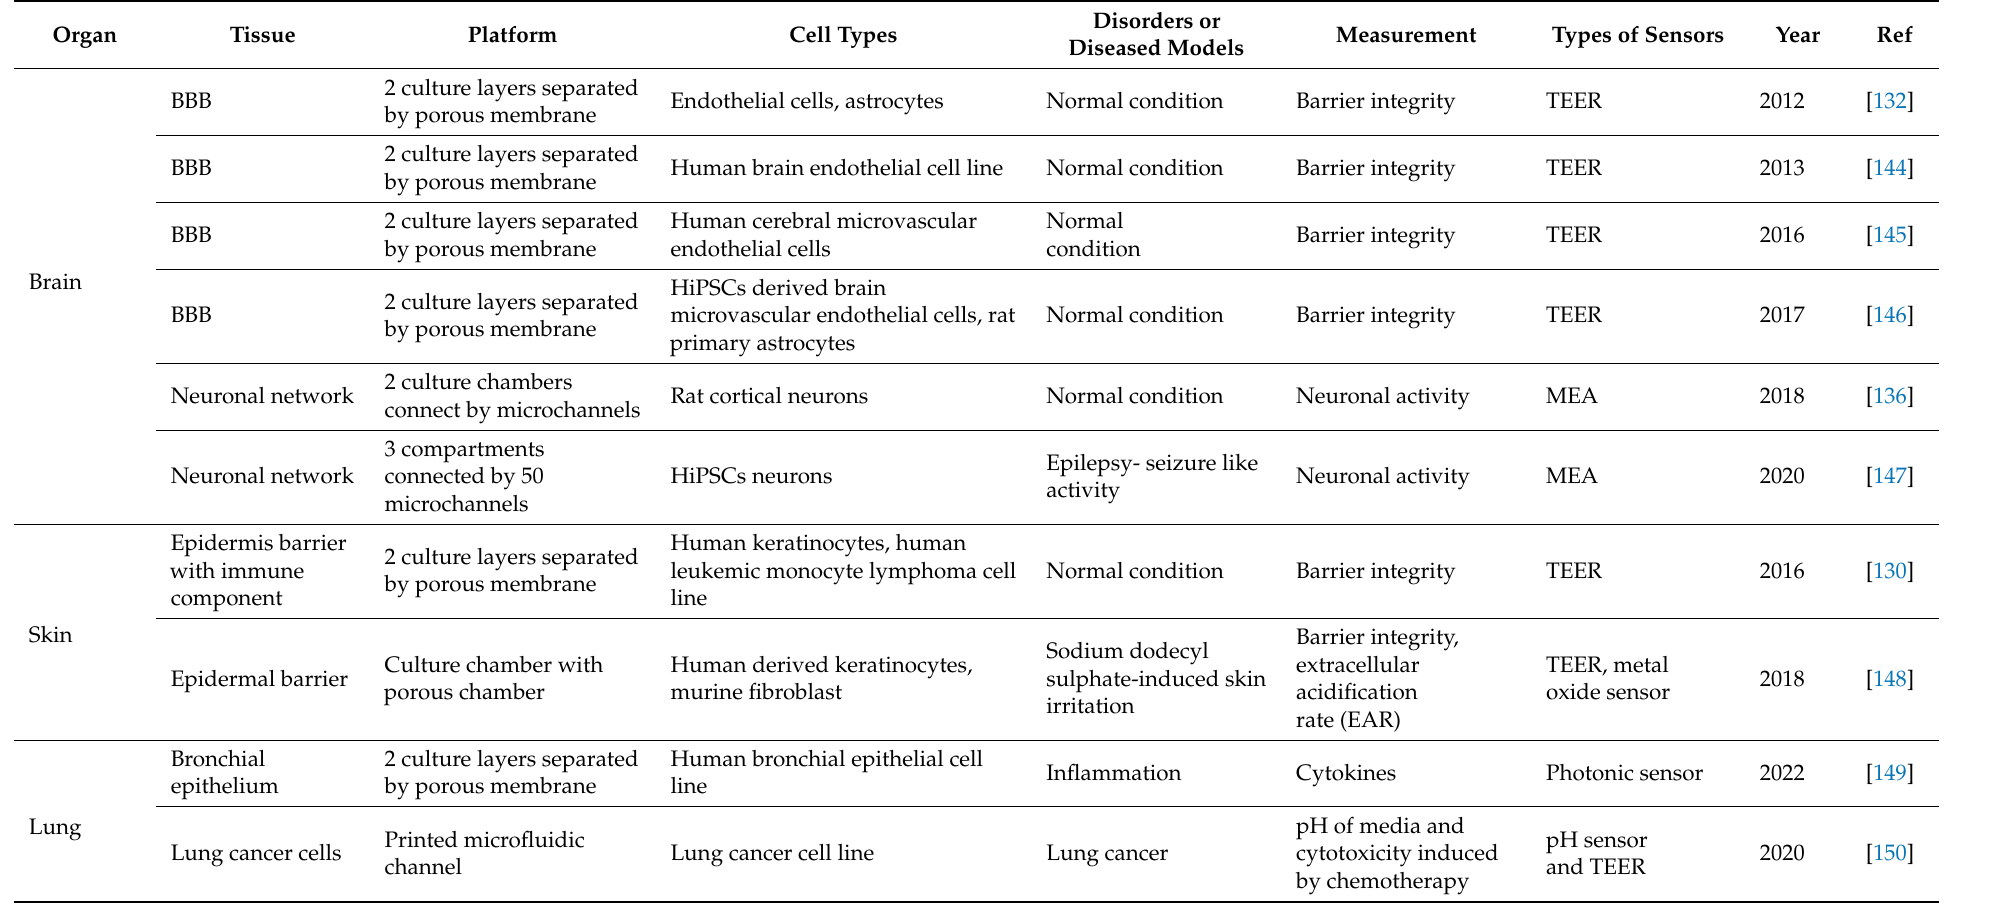
Table 2. Organ chips integrated with biosensors for real-time monitoring of cellular behaviors and drug